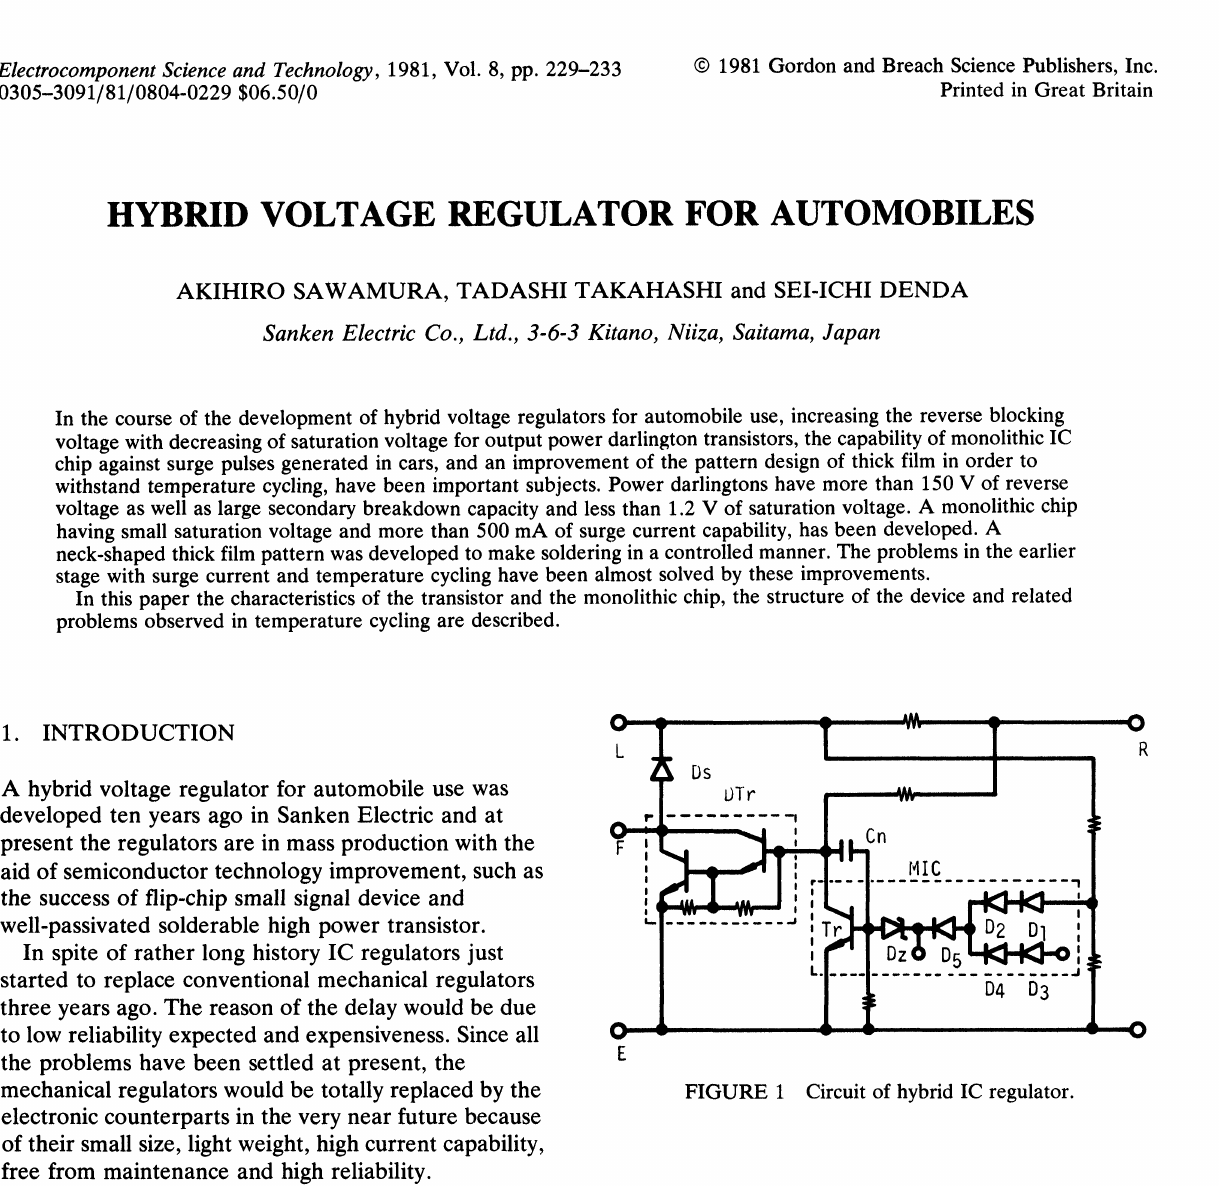
FIGURE Circuit of hybrid IC regulator.